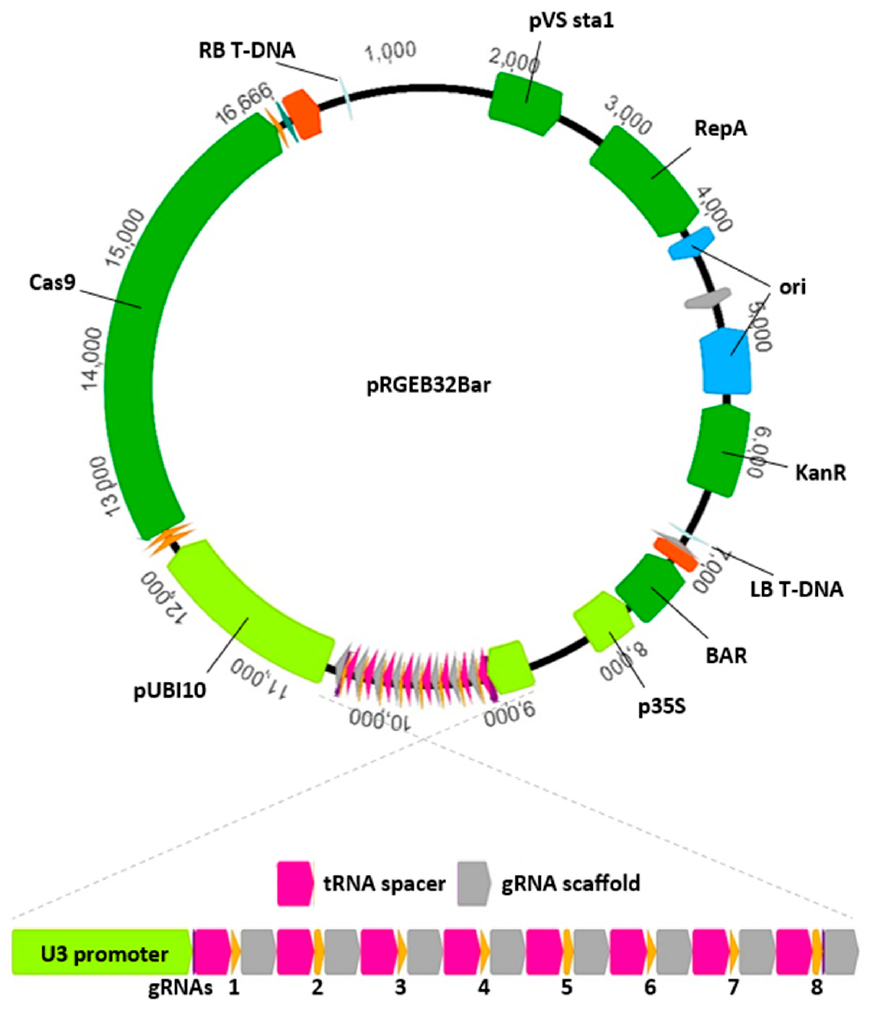
Figure 1. Diagram of the pRGEB32Bar CRISPR/Cas9 delivery vector for use in maize. The vector was modified from pRGEB32 by replacing the hygromycin selectable marker with the BAR gene that confers Basta resistance and is preferred for maize transformation. The remaining components of the vector were retained from the original pRGEB32 vector and function in both rice and maize. Components between the left (LB) and right (RB) borders constitute the transfer DNA that will be stably incorporated into the host genome. This includes expression cassettes for BAR, Cas9, and the polycistronic gRNA assembly. The rice Pol-III-driven promoter U3 drives expression of a polycistronic tRNA CRISPR assembly composed of repeated units of tRNA spacers, 20-nt CRISPR gRNAs, and gRNA scaffolds. A single transcript from this assembly will be processed by plant tRNA processing machinery to produce mature gRNA molecules. In the example presented here, the transcript will be processed into 8 mature gRNAs, each targeting a unique genomic